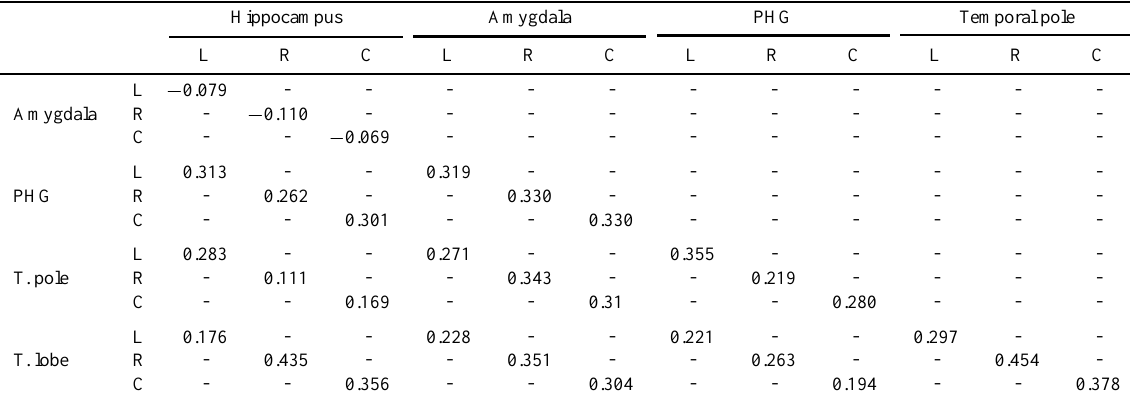
Table 3 Pearson’s product moment correlation for a linear regression analysis between the volumes of medial temporal lobe structures in the left and right cerebral hemisphere for the 29 subjects in Table 1